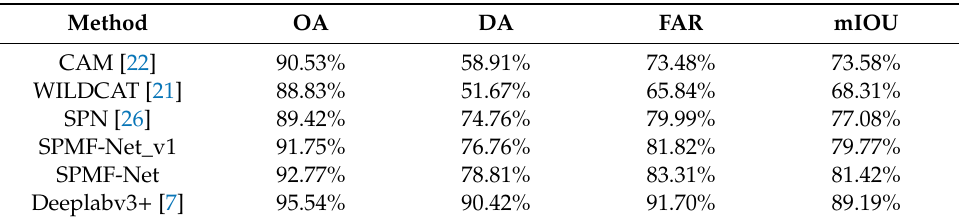
Table 2. Comparison of quantitative results on the Vaihingen